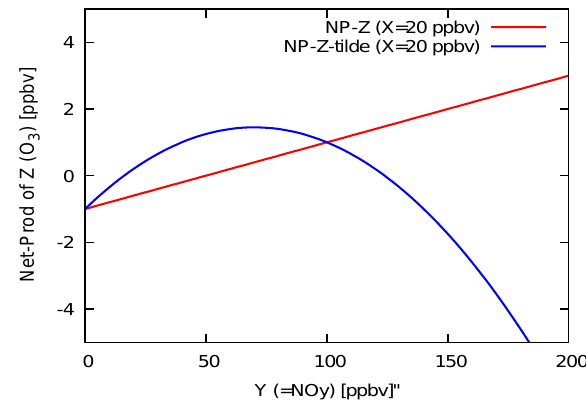
Fig. 4. Net production rates [ppbv/s] for a constant concentration of Z (red line) and ˜ Z (blue line) of 40ppbv and a mixing ratio of X =20ppbv.